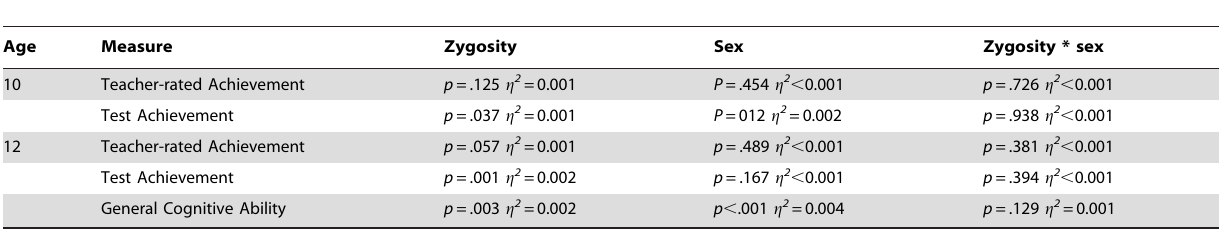
Table 2. ANOVA results showing significance and effect size, by zygosity and sex.